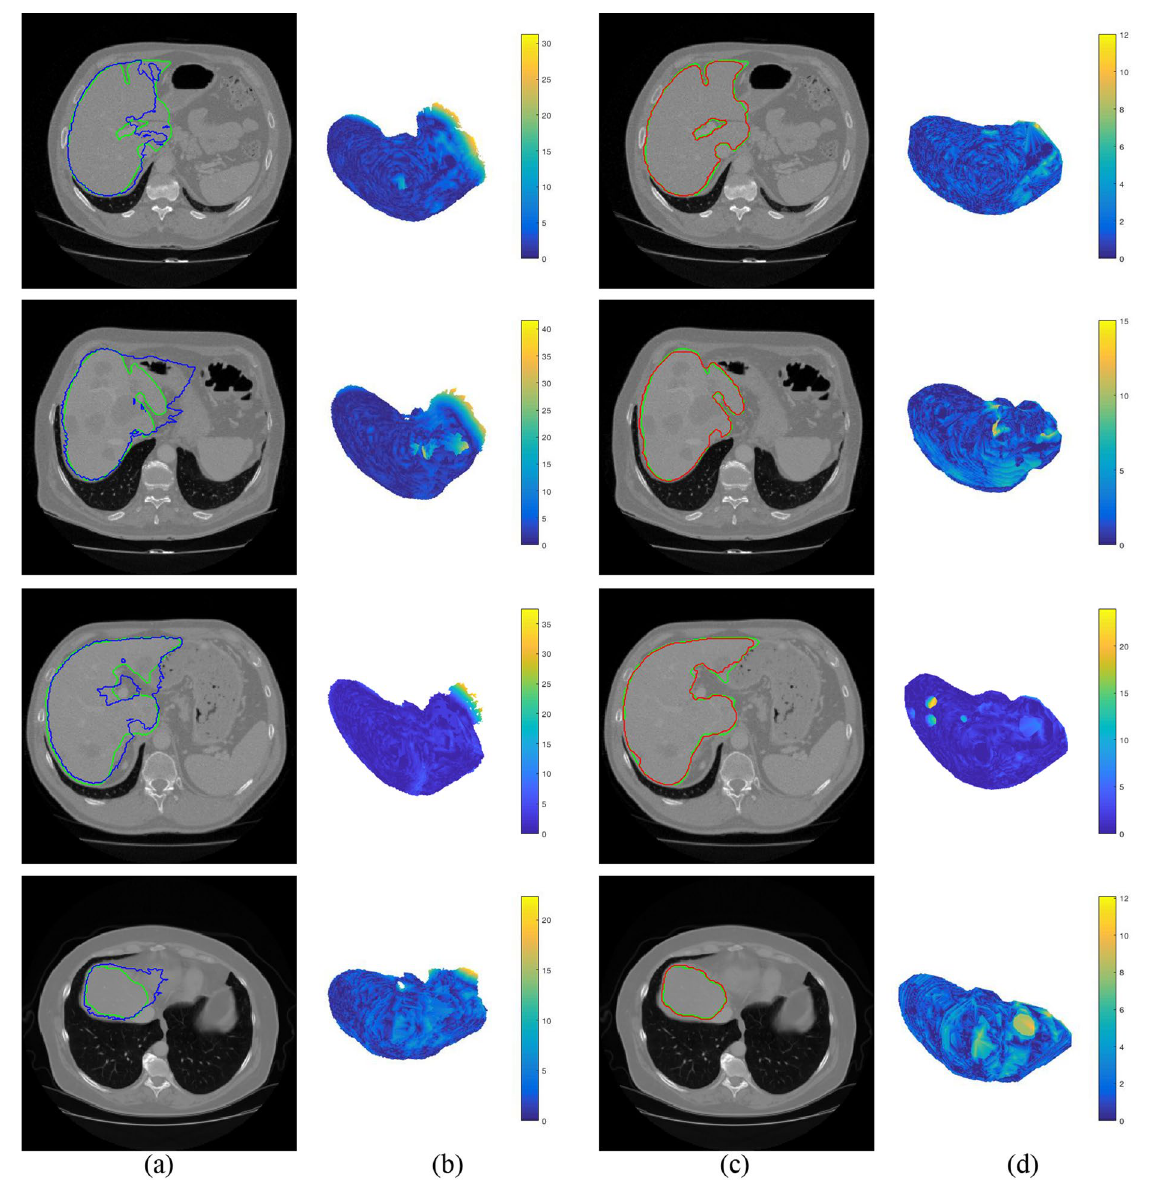
Figure 8. Liver initial and final segmentation results with four difficult cases. The ground truth is shown in green curves. ( a ) Initial segmentation (blue curves). ( b ) Surface distance between initial segmentation to ground truth. ( c ) Final segmentation (red curves). ( d ) Surface distance between final segmentation to ground